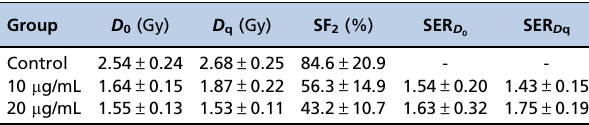
Table 2 - Radiation parameters for a single-hit multi-target